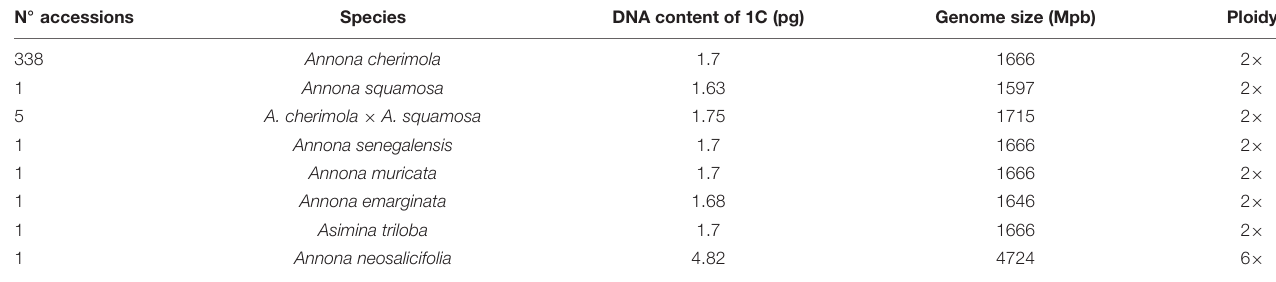
TABLE 1 | DNA ploidy levels of Annona spp. and Asimina